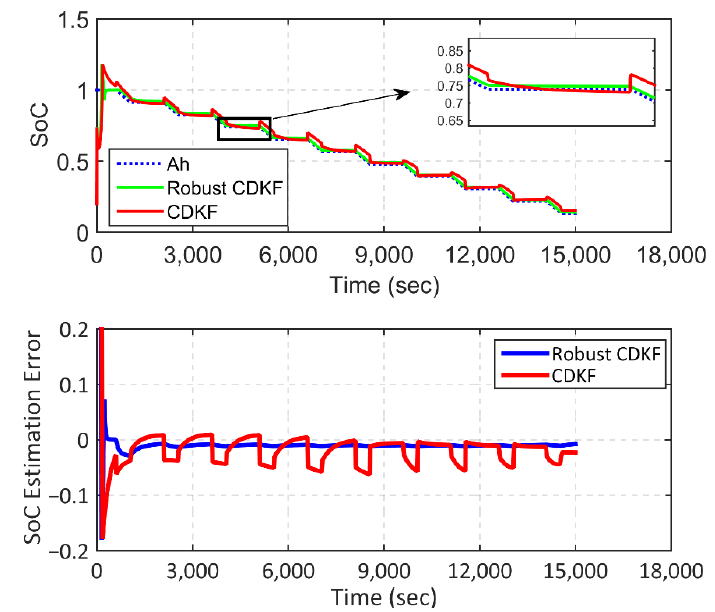
Figure 12. SoC estimation (aged battery).